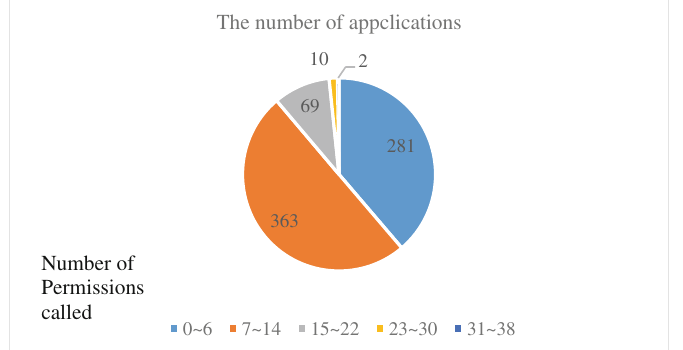
Fig. 6. The number of Apps (Color fi gure online)